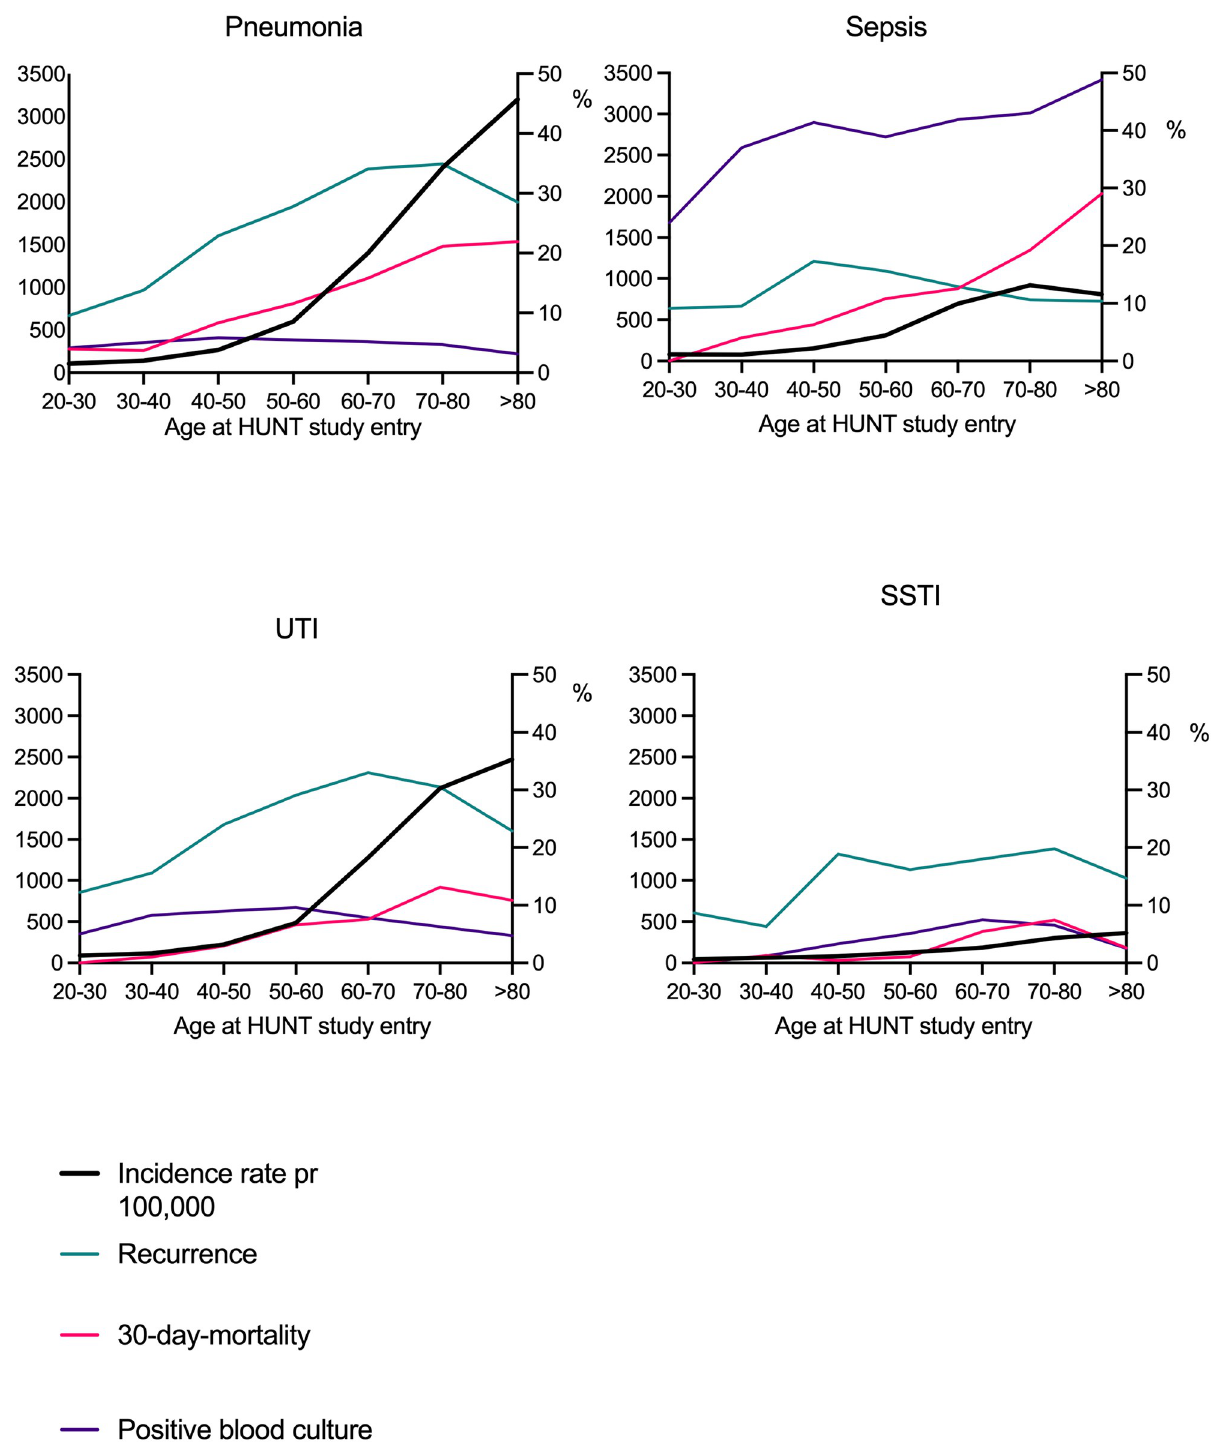
Fig 2. Incidence rates, rate of recurrent infections, 30-day-mortality rate and rate of positive blood cultures by age group. The distribution of incidence rates (black line), recurrence (green line), 30-day mortality (red line) and proportion of positive blood cultures (purple line) in the 3 chosen foci of infection and in sepsis as defined by Rudd et al. On the x-axis is the age upon entering the HUNT study. The left y-axis shows incidence rate per 100,000 per year, the right y-axis shows proportions (in %) of recurrence, 30-day mortality and positive blood cultures. UTI, urinary tract infection; SSTI, skin- and soft tissue